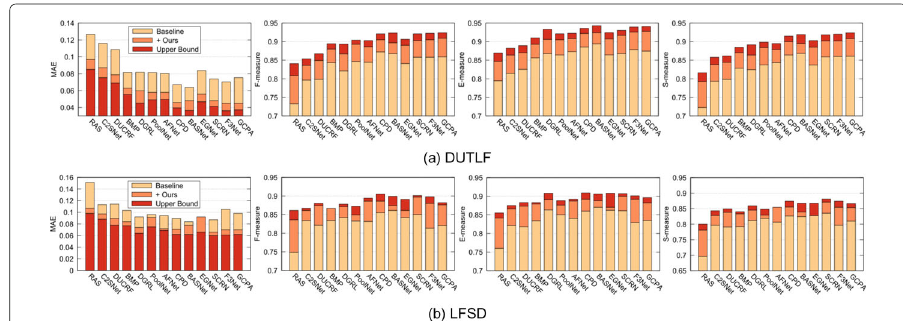
Fig. 8 Upper bound analysis of the proposed method. Baseline denotes the results of 2D methods over all-focus images, while +Ours denotes the results after the selection of our proposed method. Upperbound denotes the manually selected best results based on the E -measure. a , b The results on dataset DUTLF and LFSD, respectively